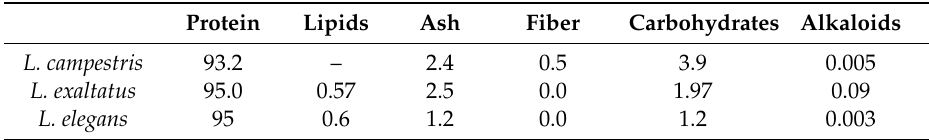
Table 9. Approximate chemical composition of protein isolates of Lupinus species from Mexico (g/100 g on dry base sample).